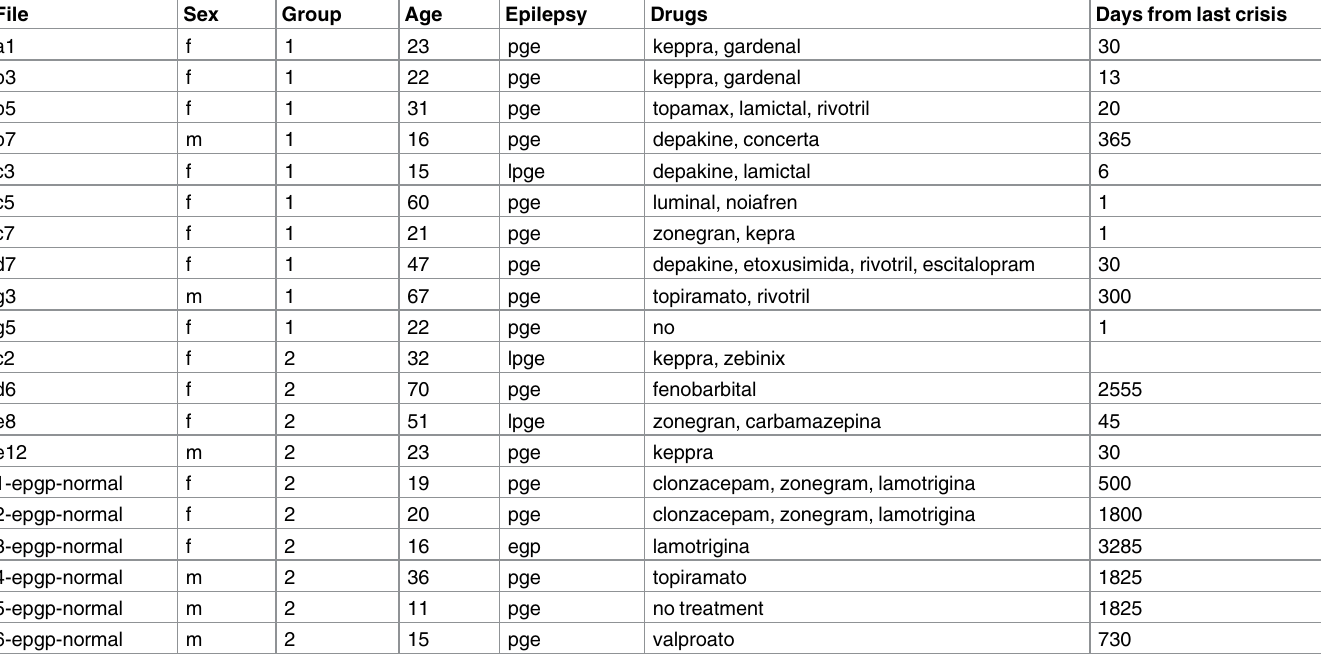
Table 1. Group 1 include the patients with abnormal EEG (although we analyze only normal periods).